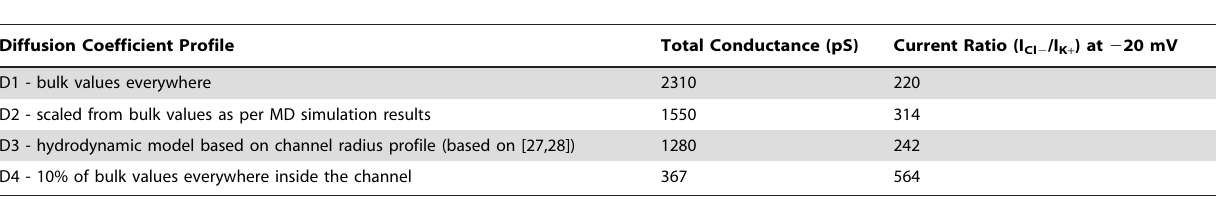
Table 2. Conductance characteristics as a function of diffusion coefficient profile.